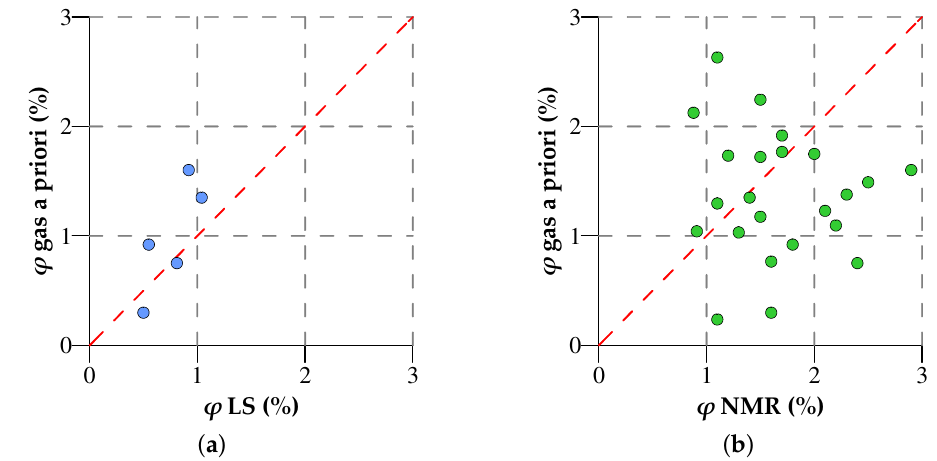
Figure 15. Liquid saturation (LS) ( a ) and NMR porosity ( b ) cross plots showing comparison with a priori data for core plugs.